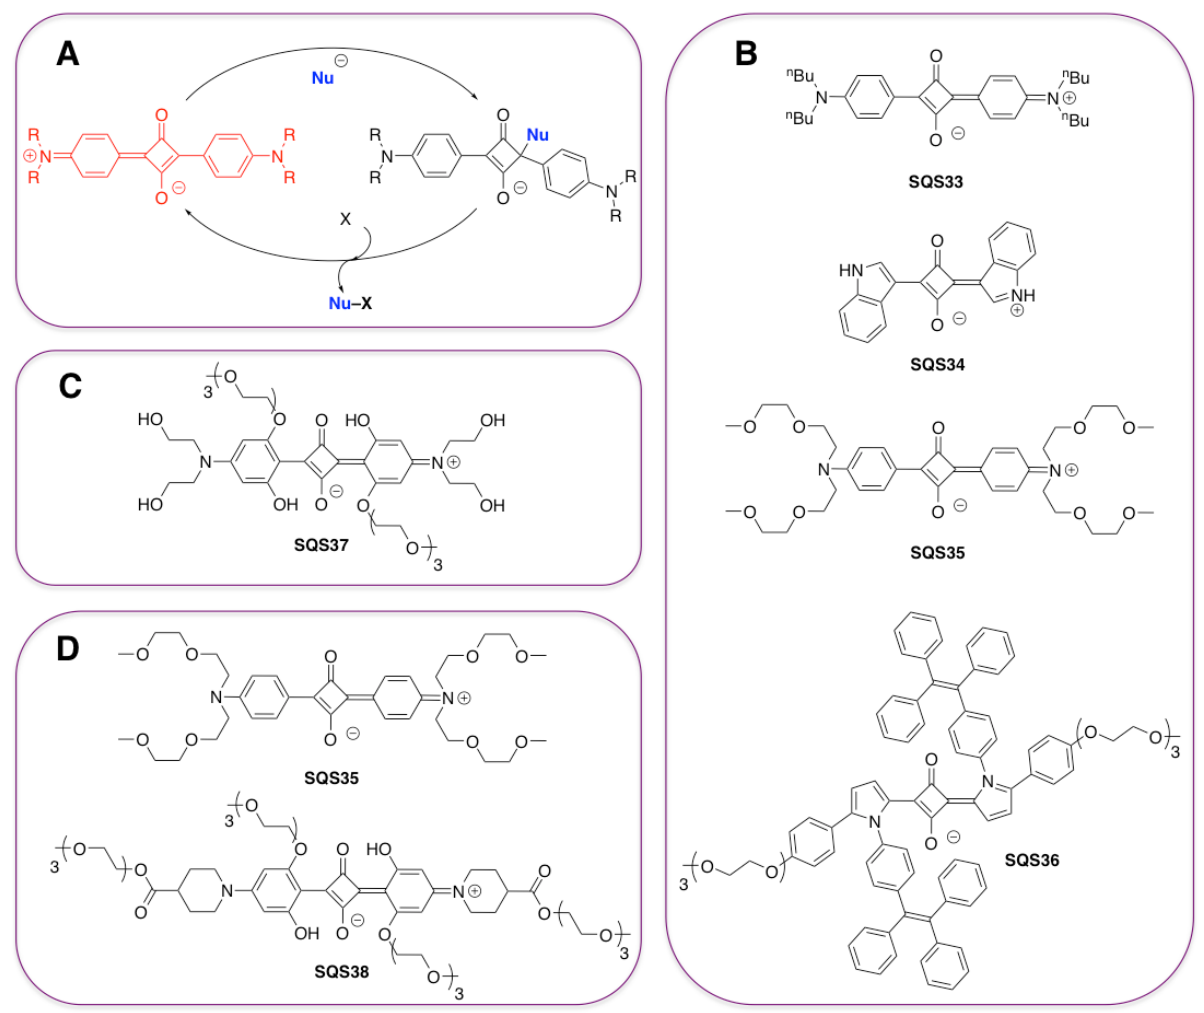
Figure 6. Some examples of nucleophile-sensitive SQSs. ON–OFF–ON relay of nucleophile-specific chemodosimeter ( A ). Representative structures of the following SQSs that showed sensitivity towards thiols ( B ): SQS33 [103], SQS34 [104], SQS35 [105], SQS36 [106]; the following to hydrazine and amines ( C ): SQS37 [107]); the following to cyanide ion ( D ): SQS38 [108], SQS39 [109]).